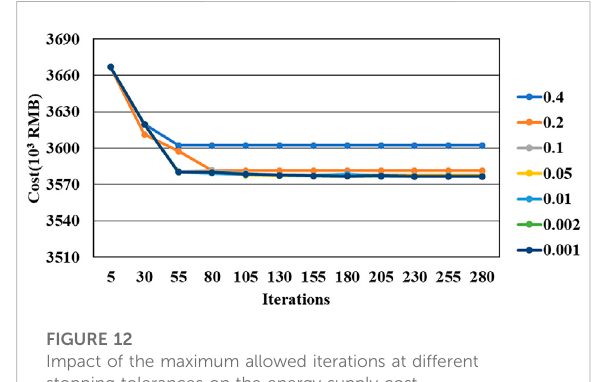
FIGURE 12 Impact of the maximum allowed iterations at different stopping tolerances on the energy supply